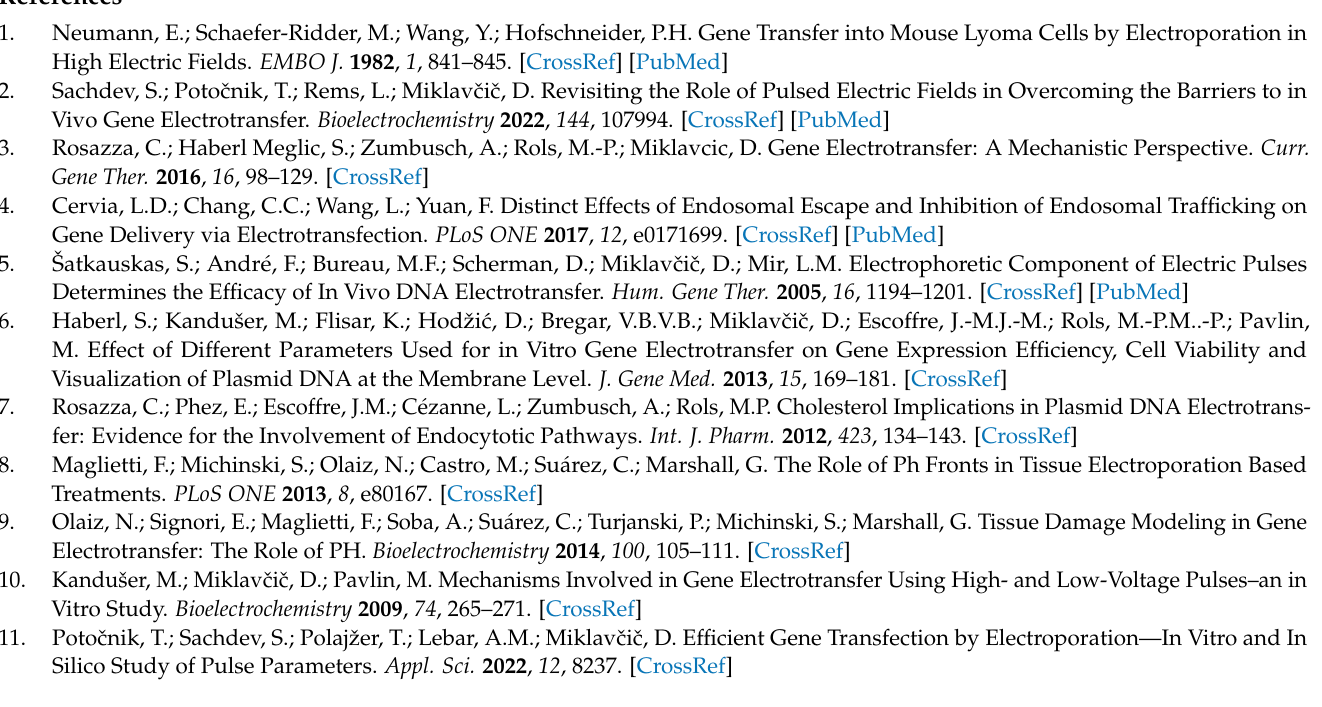
Figure S2: Commercial electroporation device manufacturers; Figure S3: Type of nucleic acid; Figure S4: Transgene coded by nucleic acid; Figure S5: Origin of cell line; Figure S6: Electroporation of cells in suspension or attached cells; List S1: A list of all 228 papers used in systematic review; Table S1: Overall GET efficiencies obtained using different experimental electrical and biological